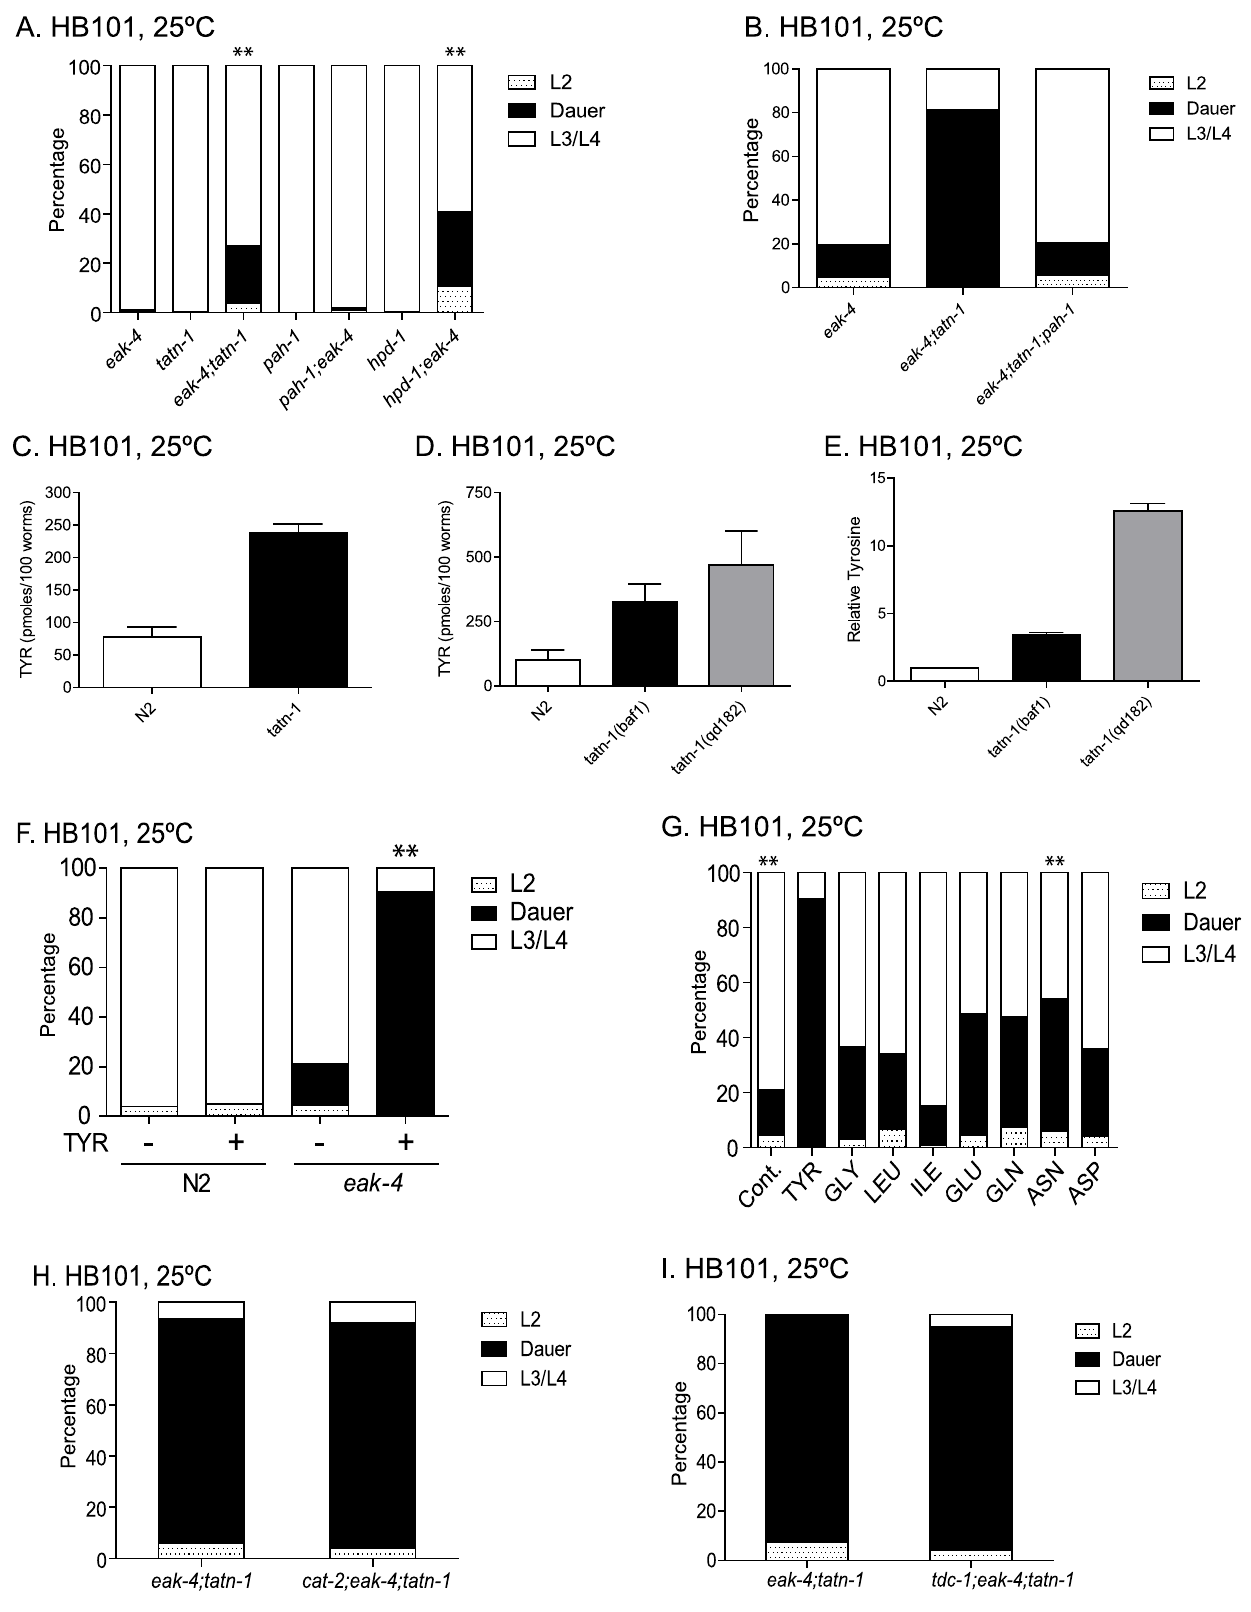
Figure 9. tatn-1 acts by increasing tyrosine levels. (A) Both tatn-1 and hpd-1 mutations augment dauer arrest by eak-4(mg348) mutants after three days at 25 u C, whereas a pah-1 mutation does not. ** p , 0.001 for comparisons between eak-4 and eak-4; tatn-1 , and hpd-1; eak-4 by Fisher’s exact test. (B) Inhibiting tyrosine synthesis with the pah-1 mutation reduces dauer formation by eak-4 ; tatn-1 mutants. (C) tatn-1(baf1) has a higher